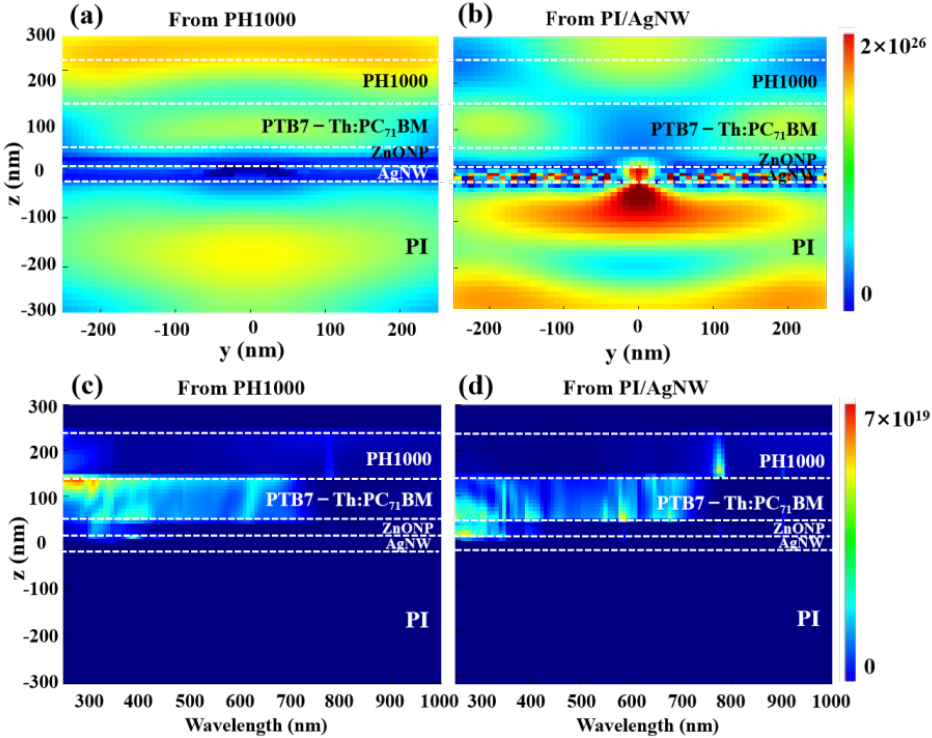
Figure 5. The contour plot of electric field (573 nm) of all-flexible semitransparent inverted solar cell illuminated from ( a ) PH1000 and ( b ) PI/AgNW. Full-wavelength absorbed power spectra of all-flexible semitransparent inverted solar cell illuminated from ( c ) PH1000 and ( d ) PI/AgNW.